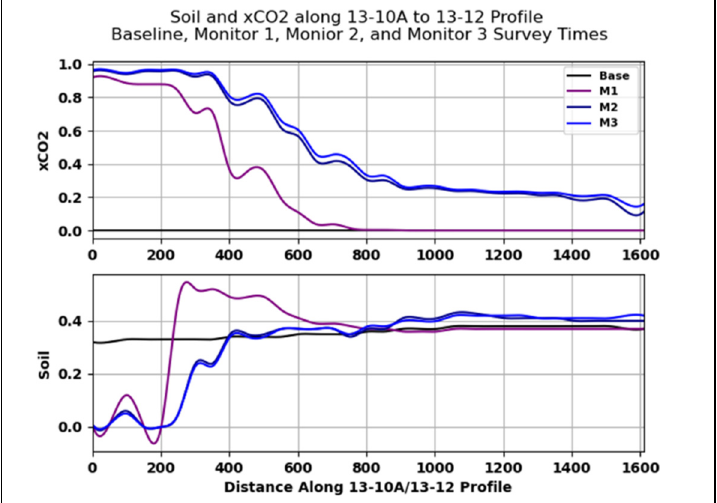
Figure 13. Simulated mole fraction of CO 2 ( top ) and oil saturation ( bottom ) along the study profile between wells 13-10A and 13-12 shown in Figures 10 and 12. Oil banking is suggested by the increase in Soil in front of the cycle 1 waterfront at the M1 survey time. The distance is in feet.